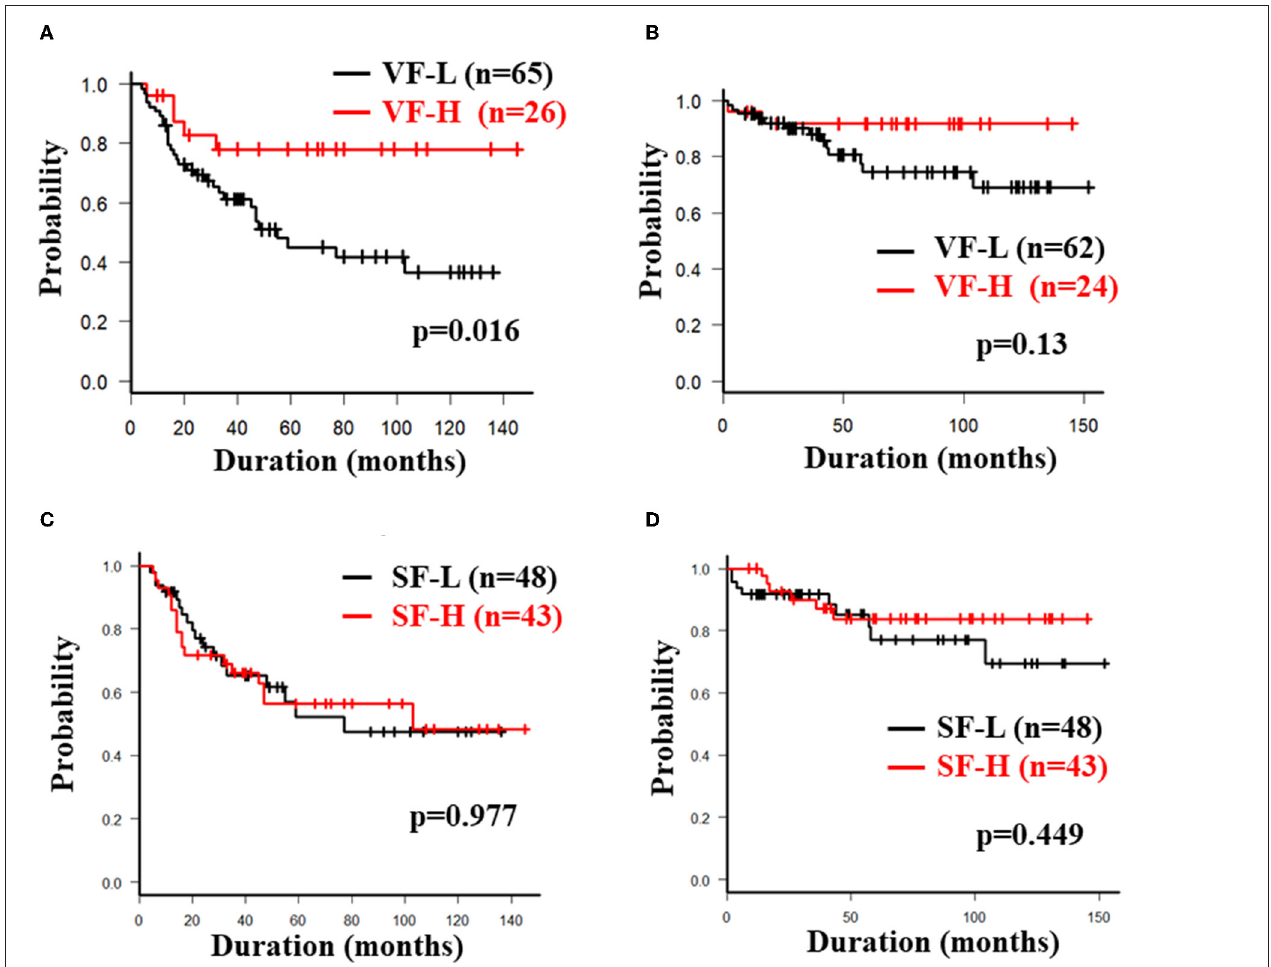
FIGURE 2 | Cumulative secondary failure-free and bowel resection-free rate classified according to the fat mass. Each figure shows the cumulative secondary failure-free rate (A) and bowel resection-free rate (B) classified according to VF, and the cumulative secondary failure-free rate (C) and bowel resection-free rate (D) classified according to